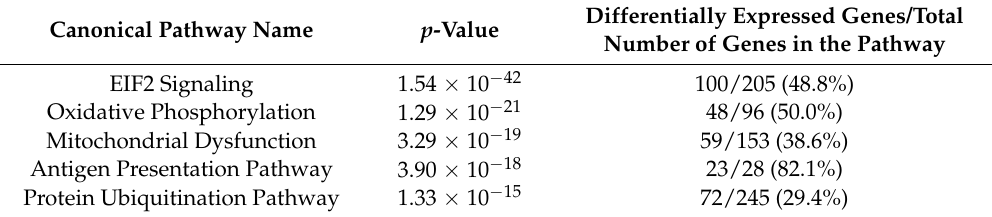
Table 3. List of five canonical pathways with the highest number of differentially expressed genes during in vivo R. conorii